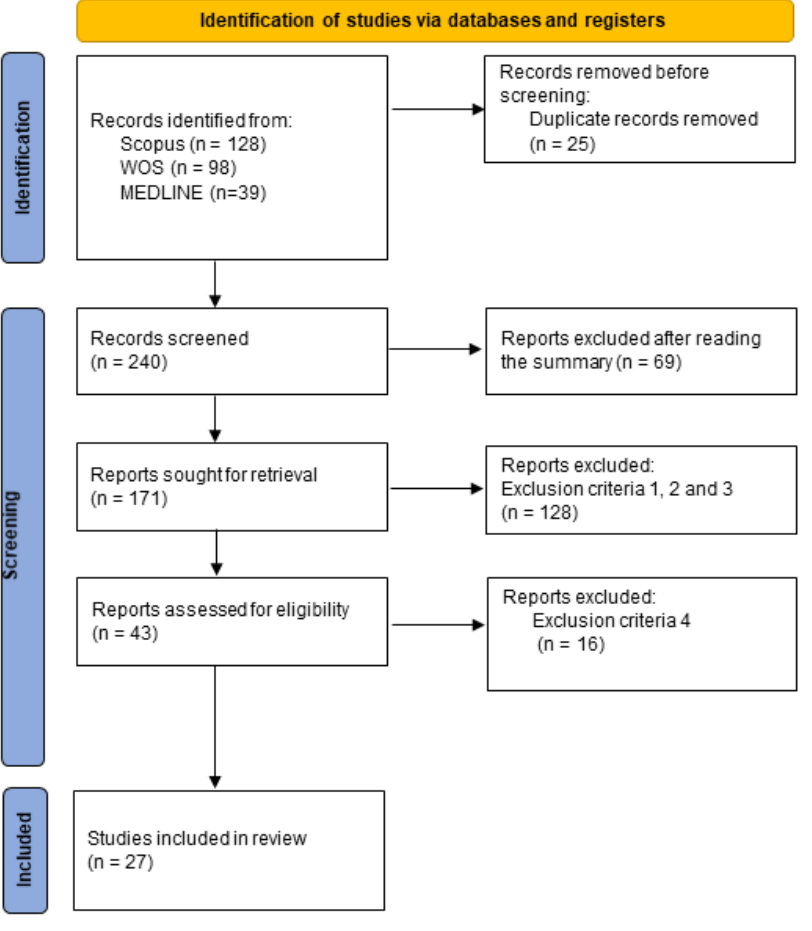
Figure 1. Research paper selection flowchart.